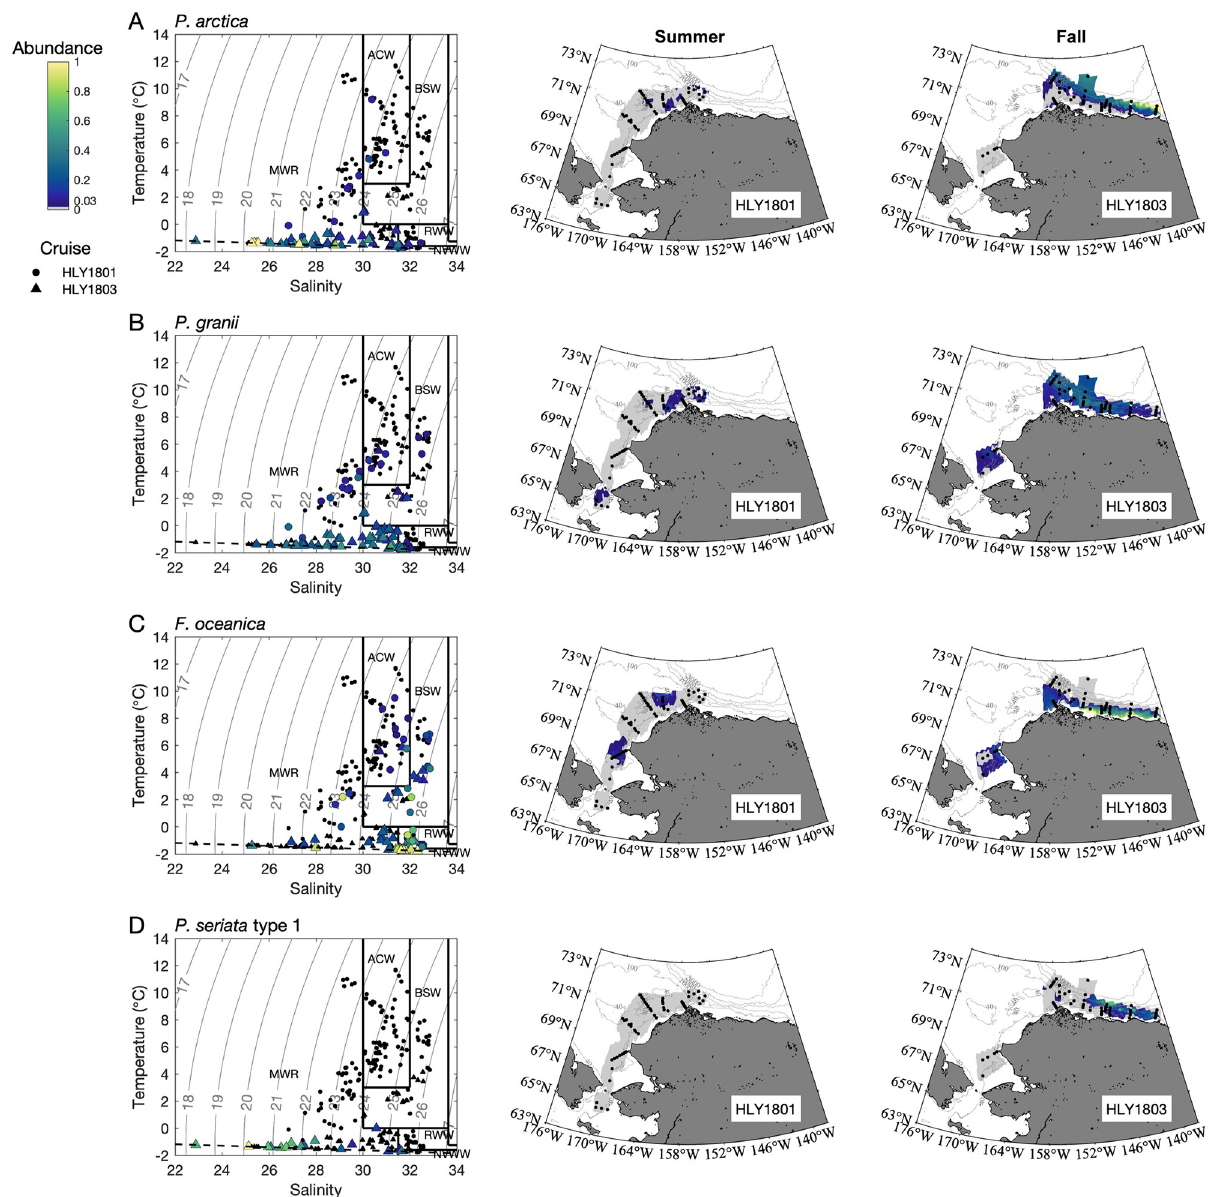
Fig 4. Distribution of species generally more prevalent in cooler water masses. Relative abundance of A) P . arctica , B) P . granii , C) F . oceanica and D) P . seriata “type 1” plotted in temperature and salinity space for all collection depths (left panels; solid lines show water mass boundaries, dotted lines show potential density, and dashed lines show freezing point of seawater) and plotted as contour plots for 10 m depth for summer ( Healy 1801; middle panels) and fall ( Healy 1803; right panels). Stations sampled during the respective cruises are indicated by black circles on the maps. Water mass abbreviations are the same as in Table